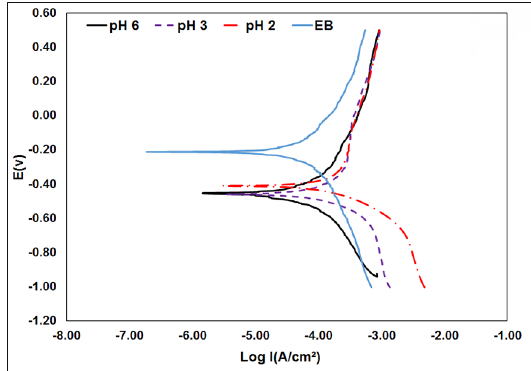
Figure 3. Anodic polarization curves of Co-Cr-Mo alloy in NaCl 0.9% solution with different pH and in mouthwash solution